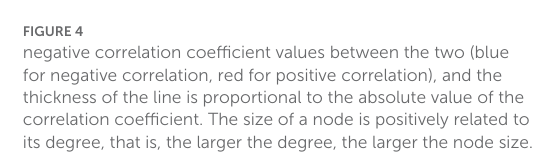
FIGURE4 negative correlation coefficient values between the two (blue for negative correlation, red for positive correlation), and the thickness of the line is proportional to the absolute value of the correlation coefficient. The size of a node is positively related to its degree, that is, the larger the degree, the larger the node